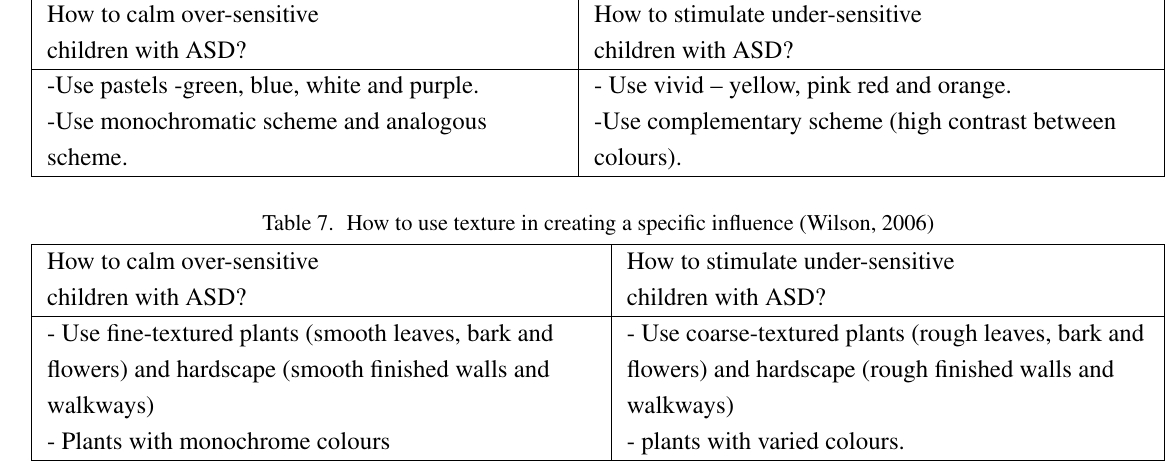
Table 5. How to use emphasis in creating a specific influence